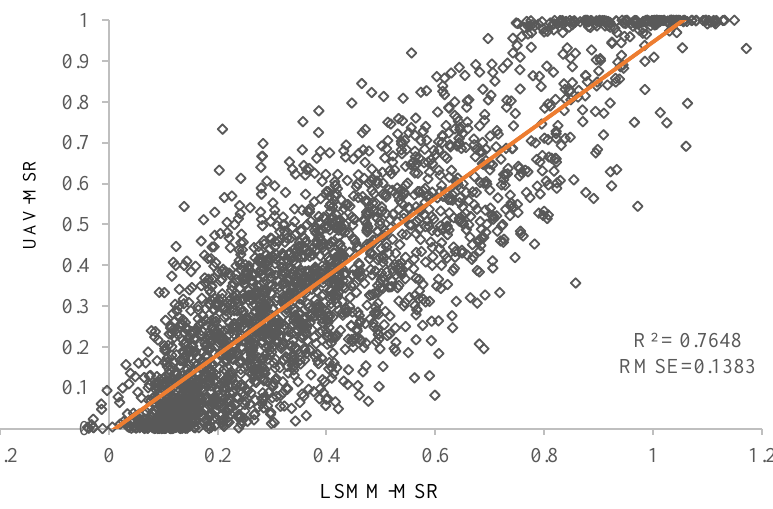
Figure 6. Linear regression analysis of the UAV-MSR and LSMM-MSR. Table 4. Extraction accuracy of the